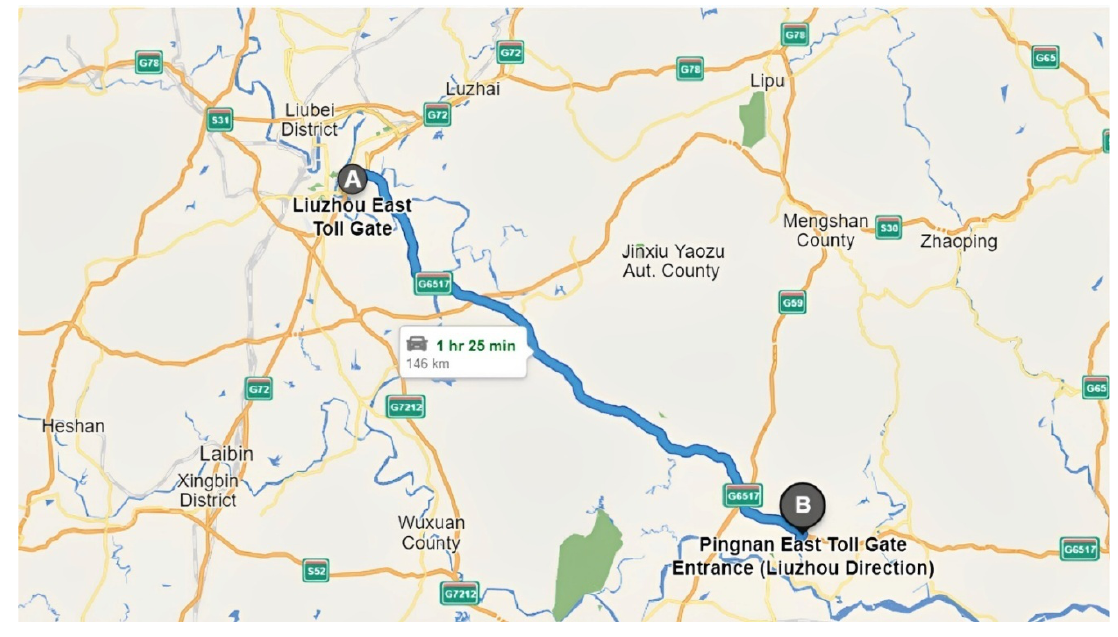
Figure 4. Driving route (Note: Point A represents Liuzhou East Toll Station, and point B represents Pingnan East toll station).